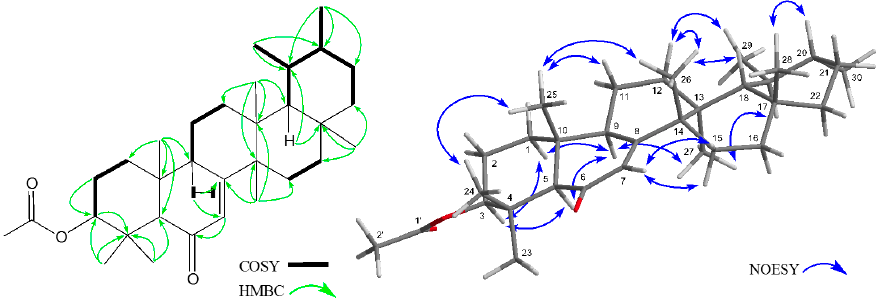
Figure 3. Key HMBC, COSY and NOESY correlations for 2 .